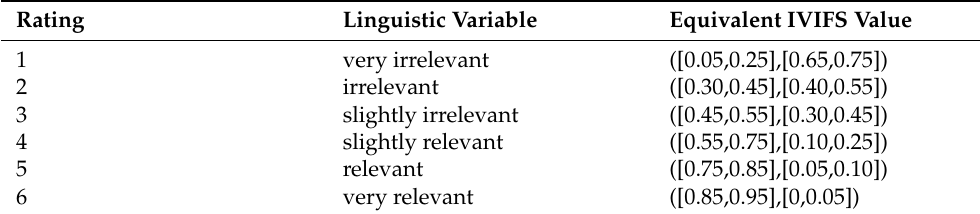
Table 10. Linguistic evaluation scale for rating the restaurants.